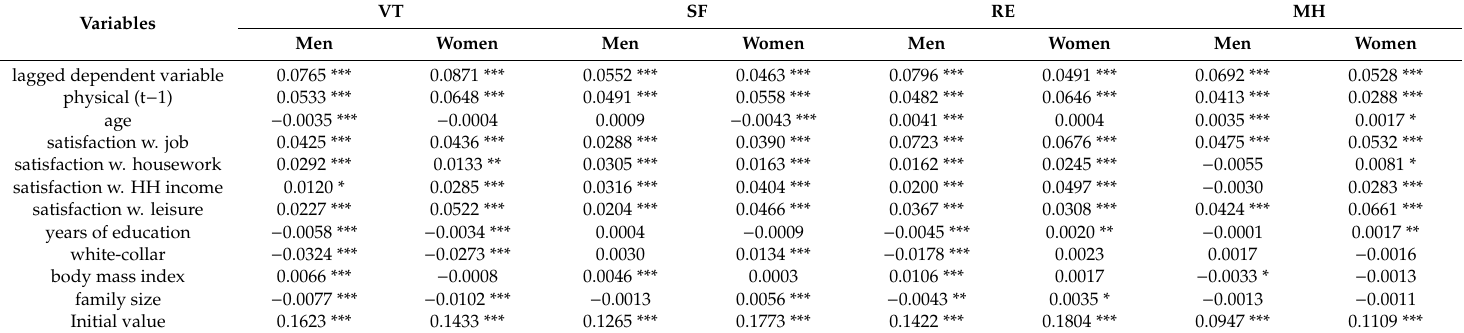
Table 7. Estimation results: average partial e ff ects of mental-related